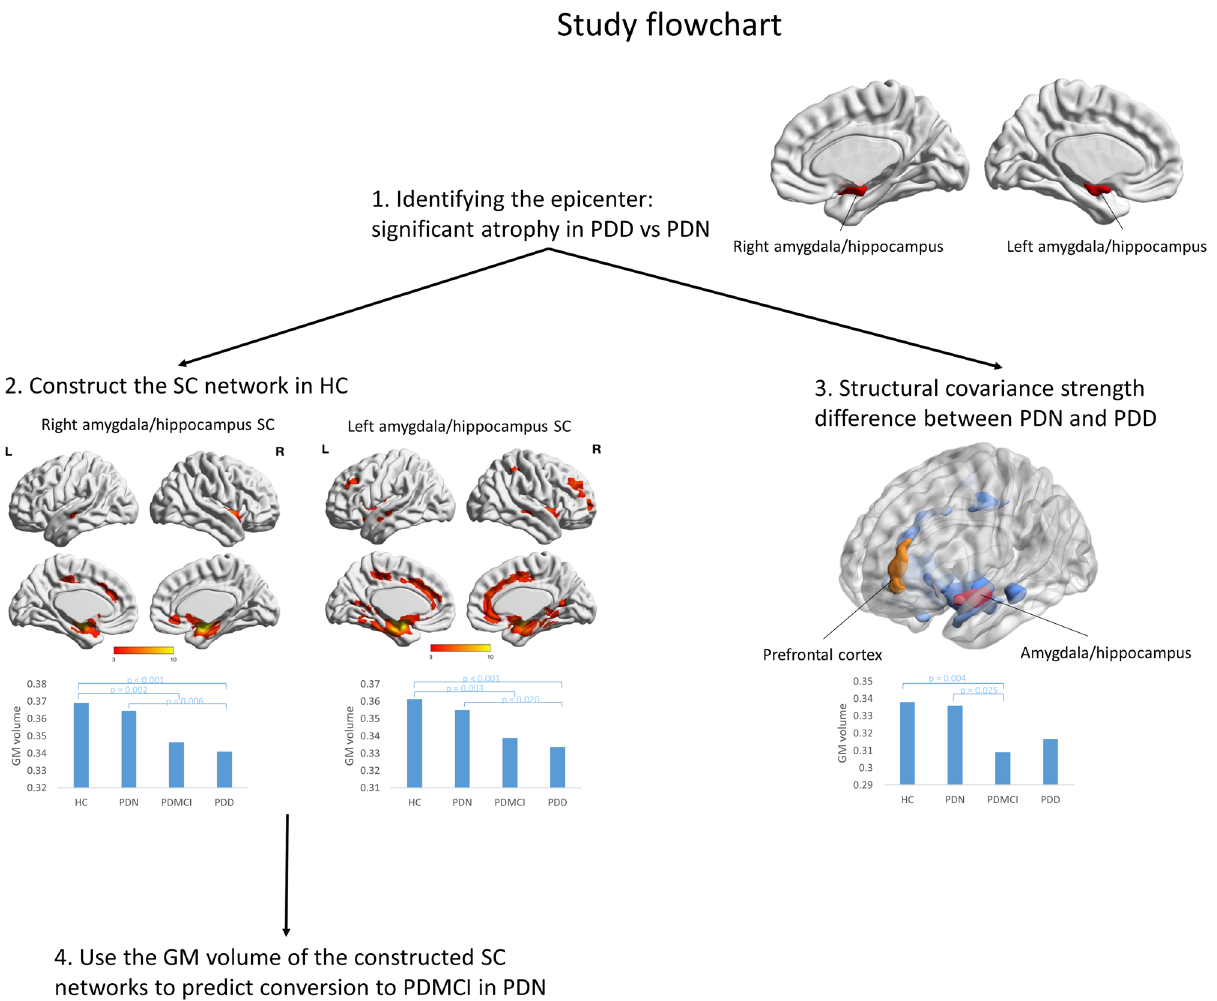
Figure 1. Study flowchart. Step 1. Voxel-wise group comparisons of GMV between PDD and PDN showing atrophy of bilateral amygdala/hippocampus in the PDD group. Step 2. ROIs identified in Step 1 were used to contrast SCN in the normal controls. Step 3. Different structural covariance patterns were analyzed between PDN and PDD (FWE-corrected P < 0.05). Step 4. The GMV of the regions found in Step 2 were calculated and used to predict conversion to PDMCI in PDN patients at 1-year